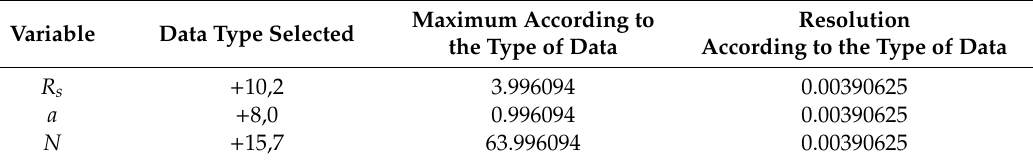
Figure 7. Behavior of the values R s , a and N . Table 2. Weights assigned to the variables R s , a and N .